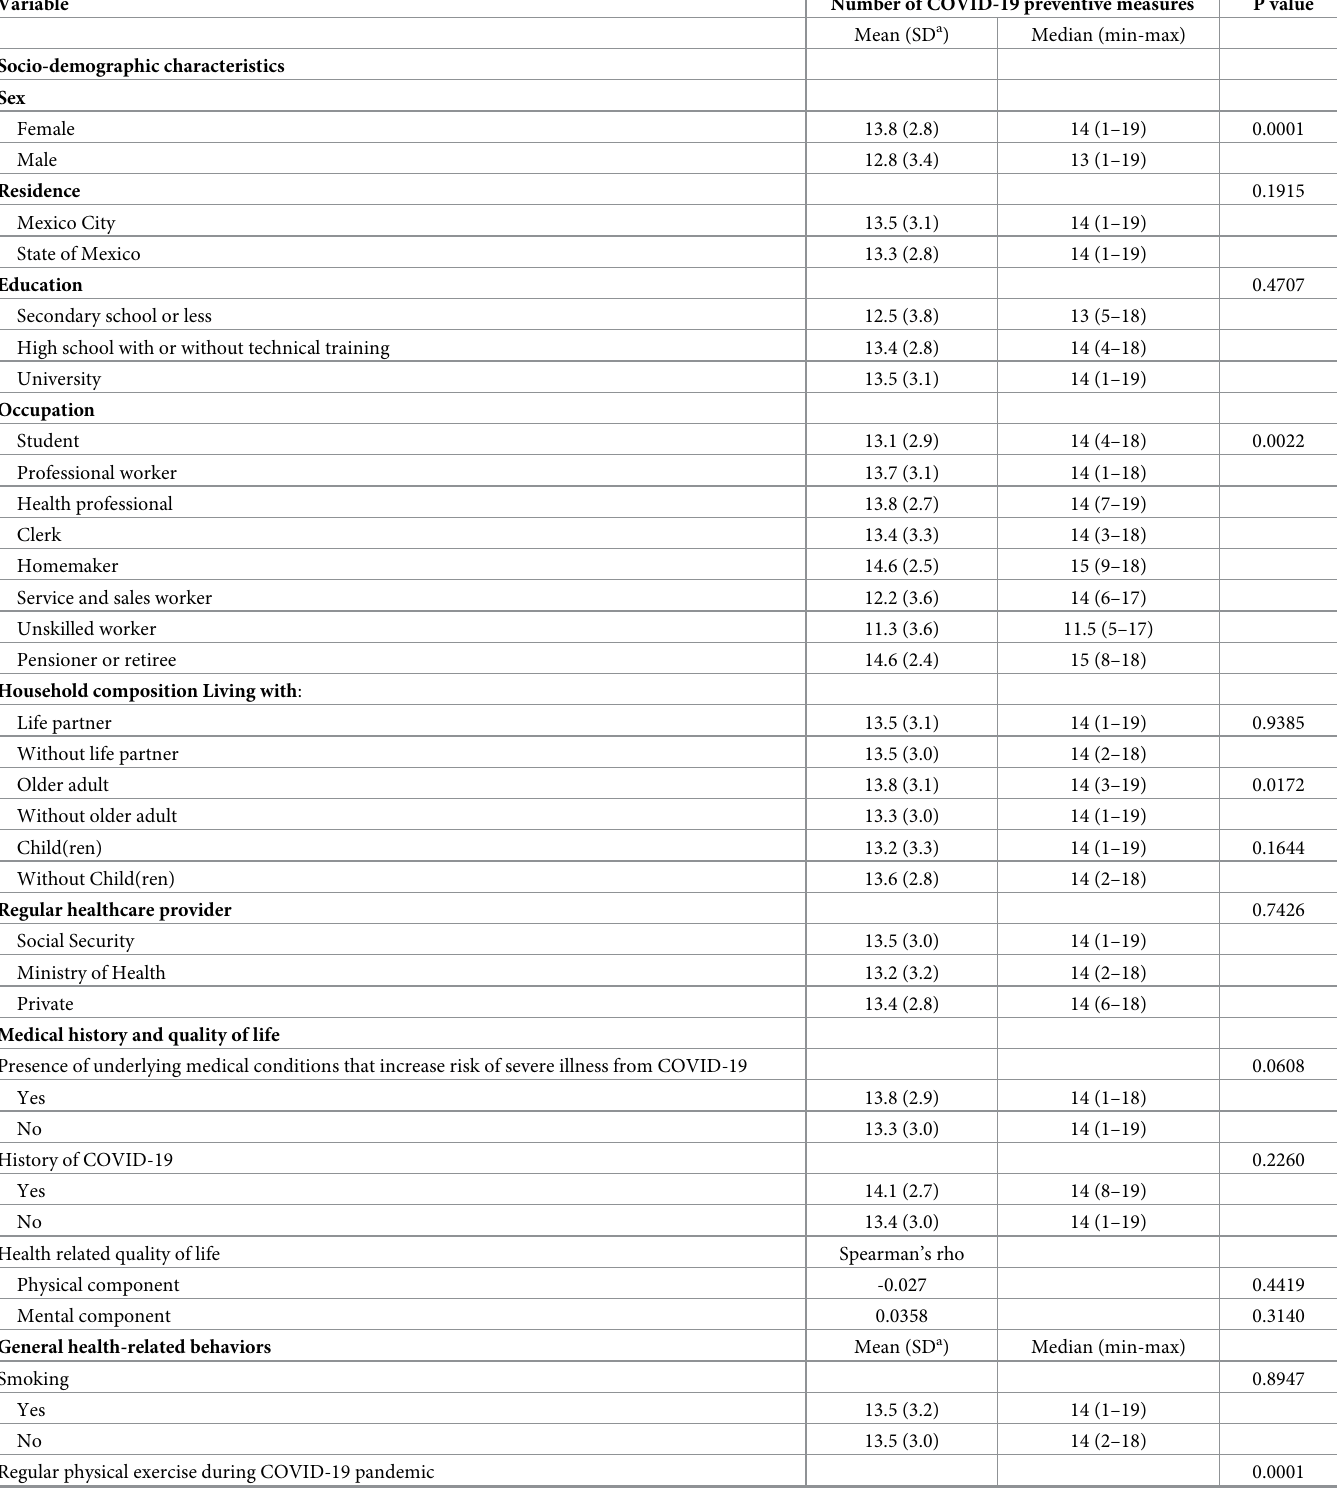
Table 3. Number of COVID-19 preventive actions used by participants according to their characteristics (n =